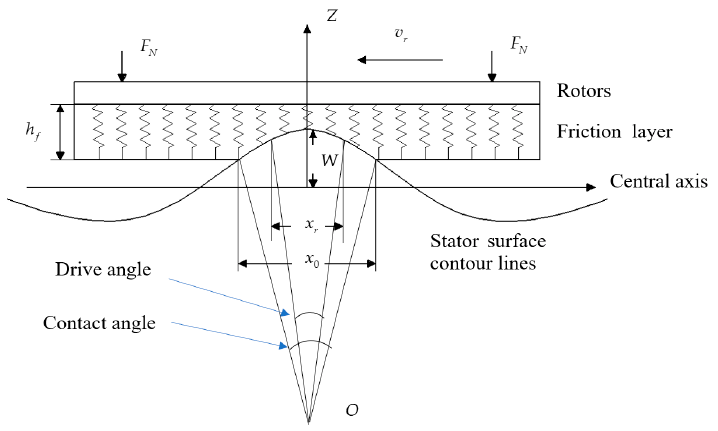
Figure 1. Model drawing of a wire spring at the stator–rotor contact interface.